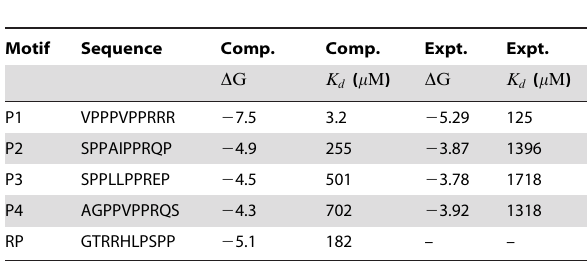
Table 2. Binding Energies of motifs to C-SH3 domain of